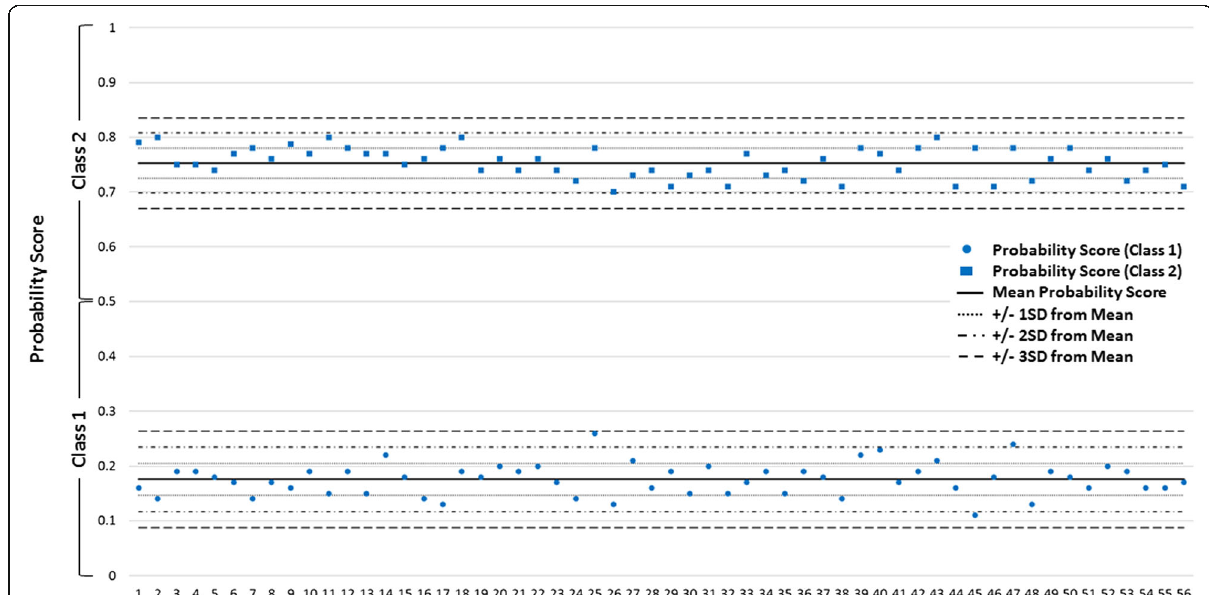
Fig. 2 Levey-Jennings analysis for positive control samples across 56 experiments. Reproducibility of assay performance for one Class 1 and one Class 2 positive control cDNA sample is shown. Probability scores were recorded from experiment to experiment over a 3 month period and across multiple lots of